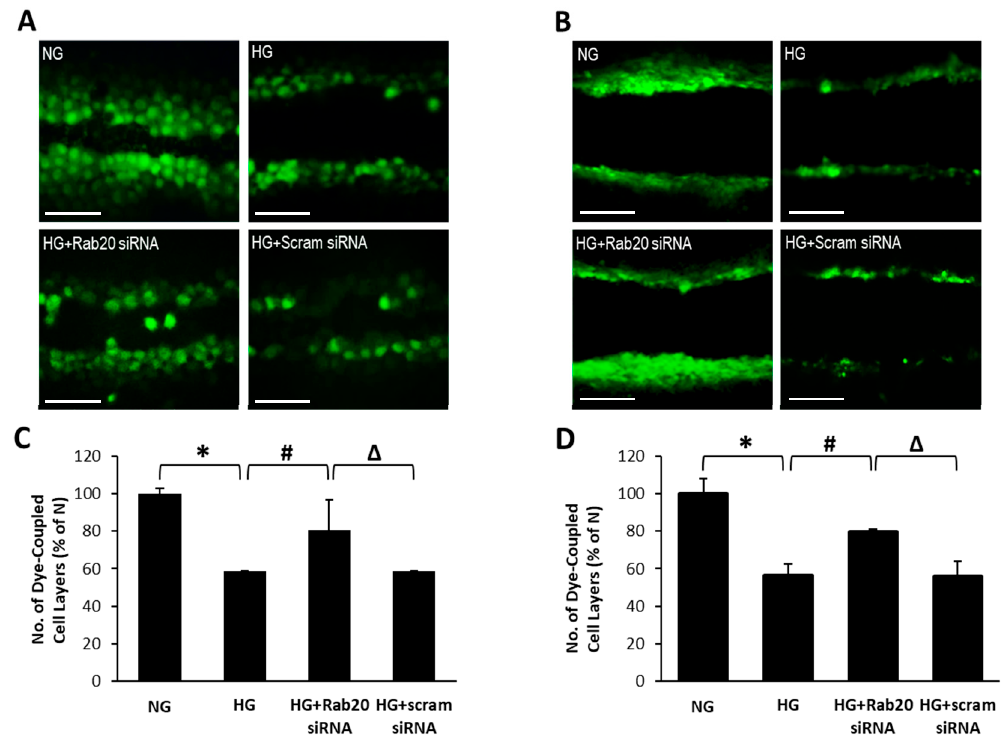
Figure 3. Rab20 downregulation lessens HG-induced decrease in gap junction intercellular communication (GJIC) in RRECs and rMC-1. Representative scrape load dye transfer (SLDT) images show ( A ) RRECs or ( B ) rMC-1 grown in HG exhibit a decrease in the number of dye-coupled cell layers. Scale bar = 100 µ m. Graphical illustration of cumulative SLDT data shows siRNA-mediated Rab20 downregulation improves GJIC activity in ( C ) RRECs (* p < 0.01, n = 6; # p < 0.05, n = 6; ∆ p < 0.05, n = 6) and ( D ) rMC-1 (* p < 0.05, n = 6; # p < 0.05, n = 6; ∆ p < 0.05, n = 6) grown in HG condition. Data are expressed as mean ± SD.